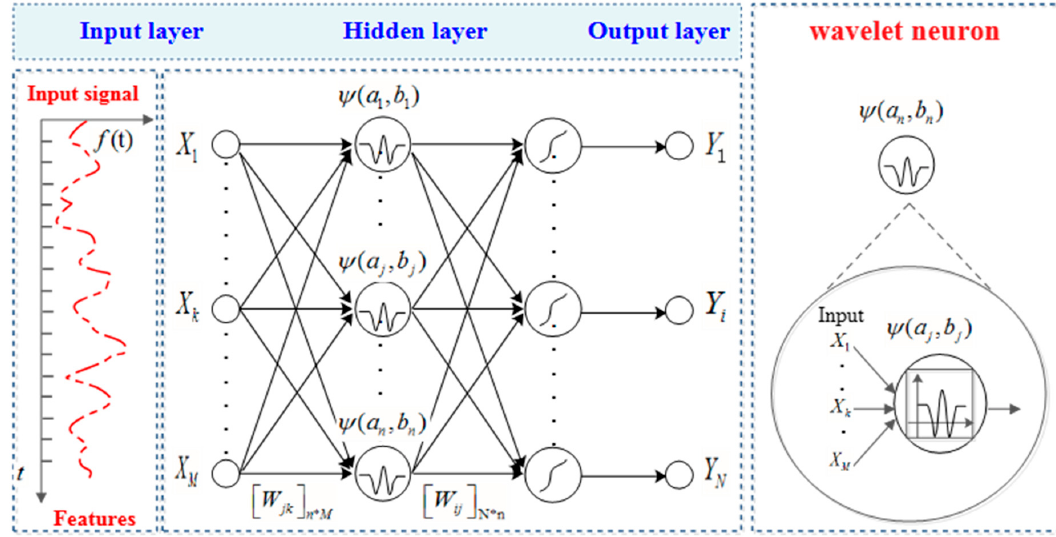
Figure 8. Wavelet neural network architecture with a single hidden layer.